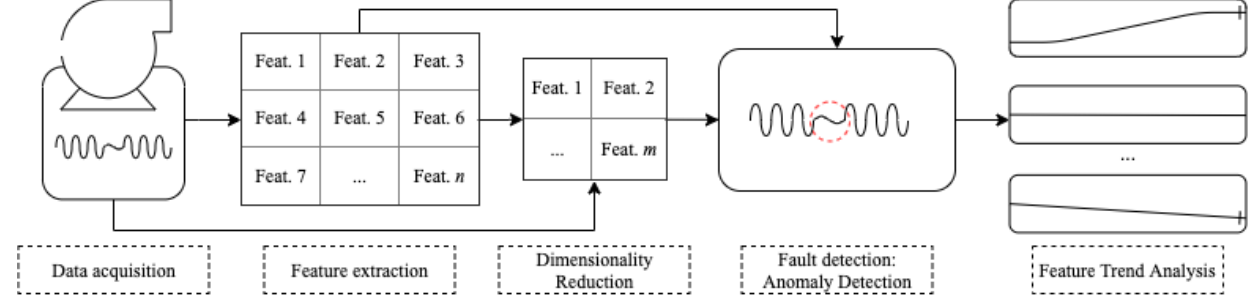
Figure 2. General framework of the proposed